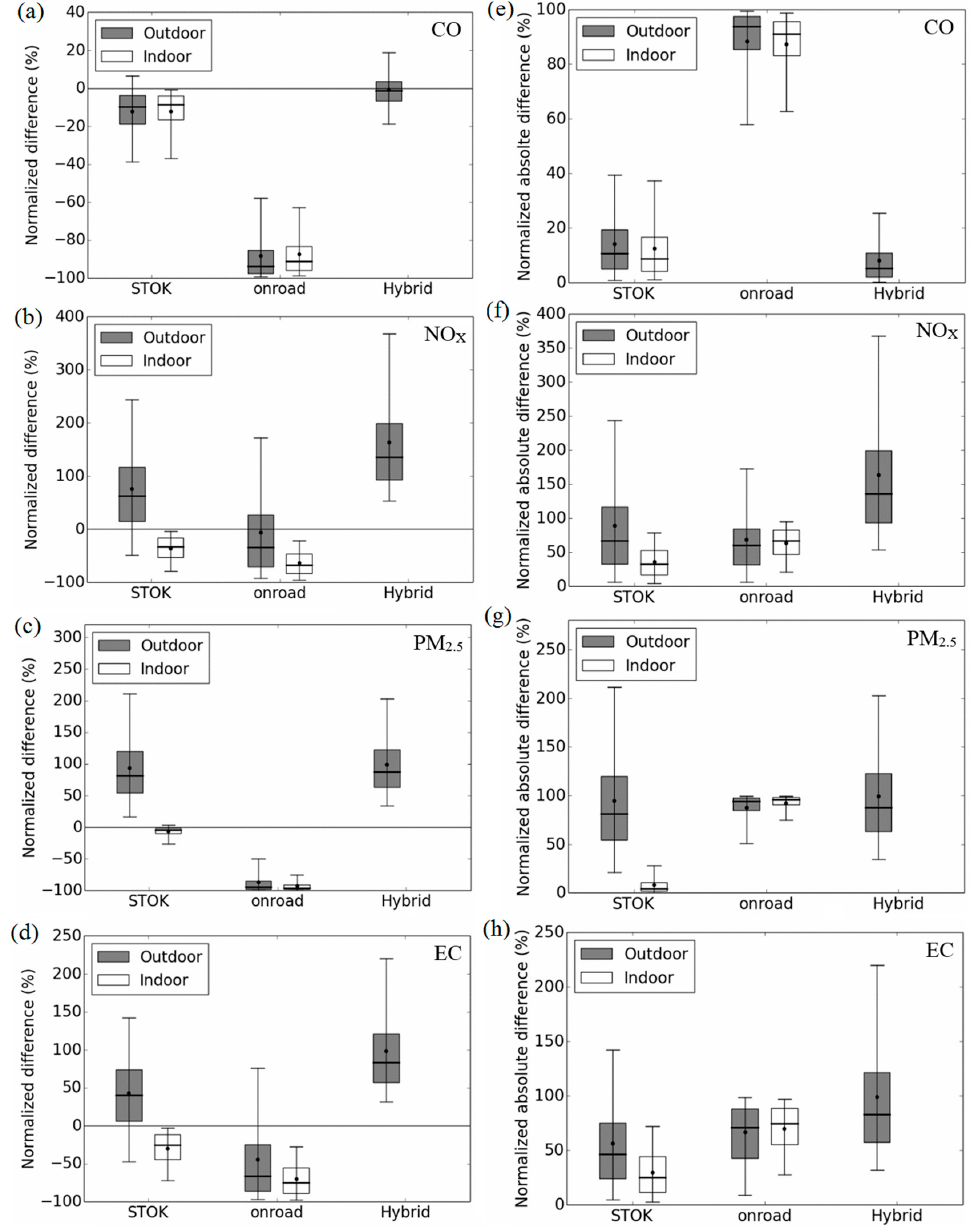
Figure 7. Hourly normalized difference ( ND , left panels ) and hourly normalized absolute difference ( NAD , right panels ) for each Census block for CO ( a and e ), NO x ( b and f ), PM 2.5 ( c and g ), and EC ( d and h ). Bottom and top of box represents 25th and 75th percentiles, the line in the middle of the box is the median, the ends of the whisker are the 5th and 95th percentiles, and the dot on the whisker is the mean.